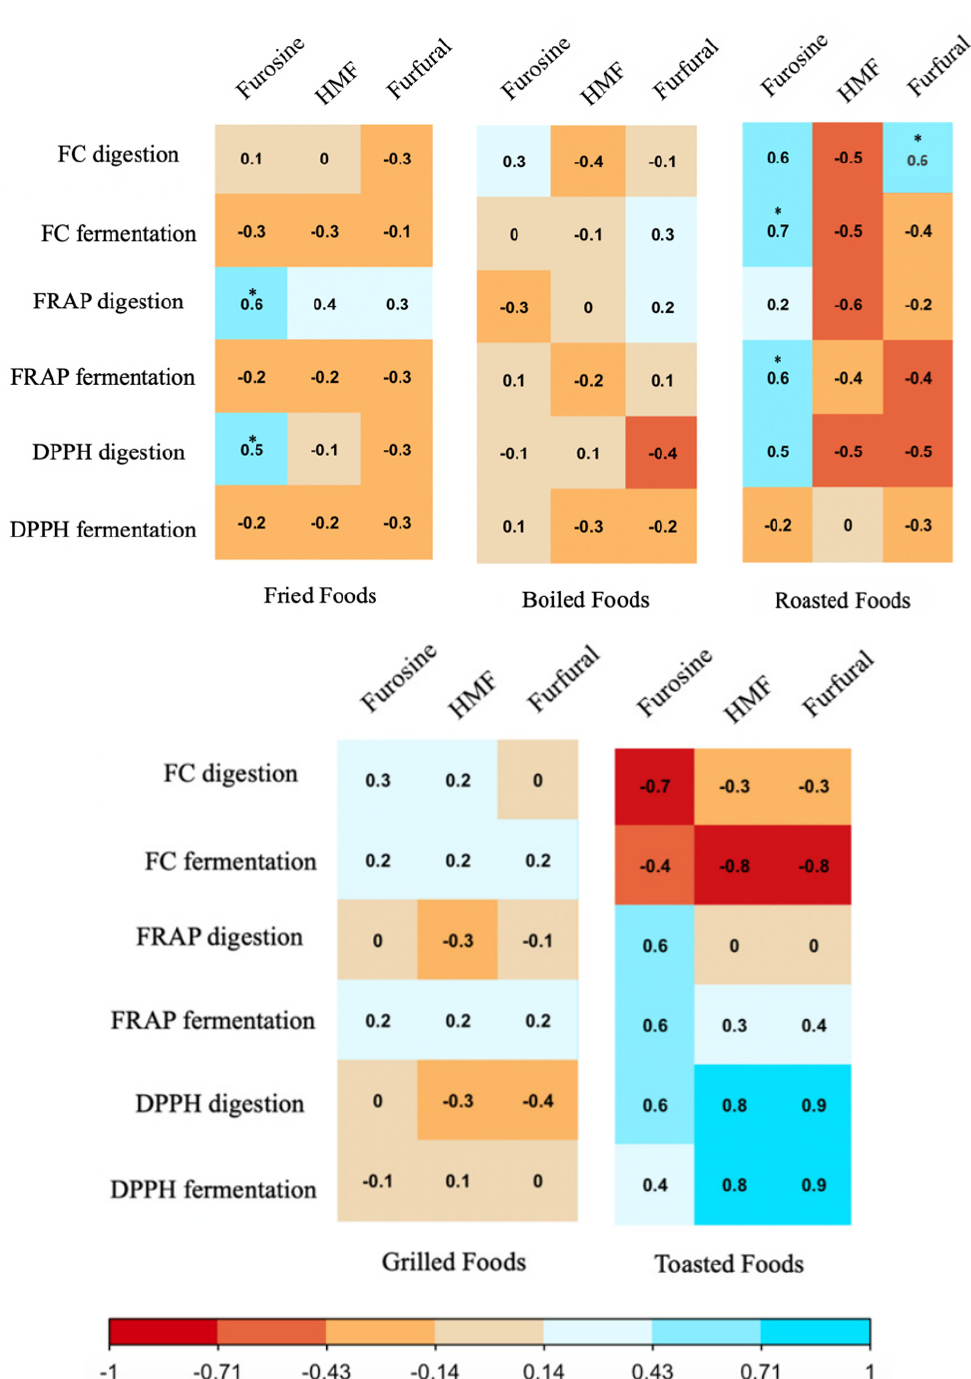
Figure 4. Correlations between heat damage markers (furosine, HMF and furfural) and antioxidant capacity measured via Folin–Ciocalteu (FC) (mg gallic acid equivalents/kg of food), FRAP (mmol Trolox equivalents/kg of food) and DPPH (mmol Trolox equivalents/kg of food) depending on the type of cooking applied. Statistic labels: *: p < 0.05.